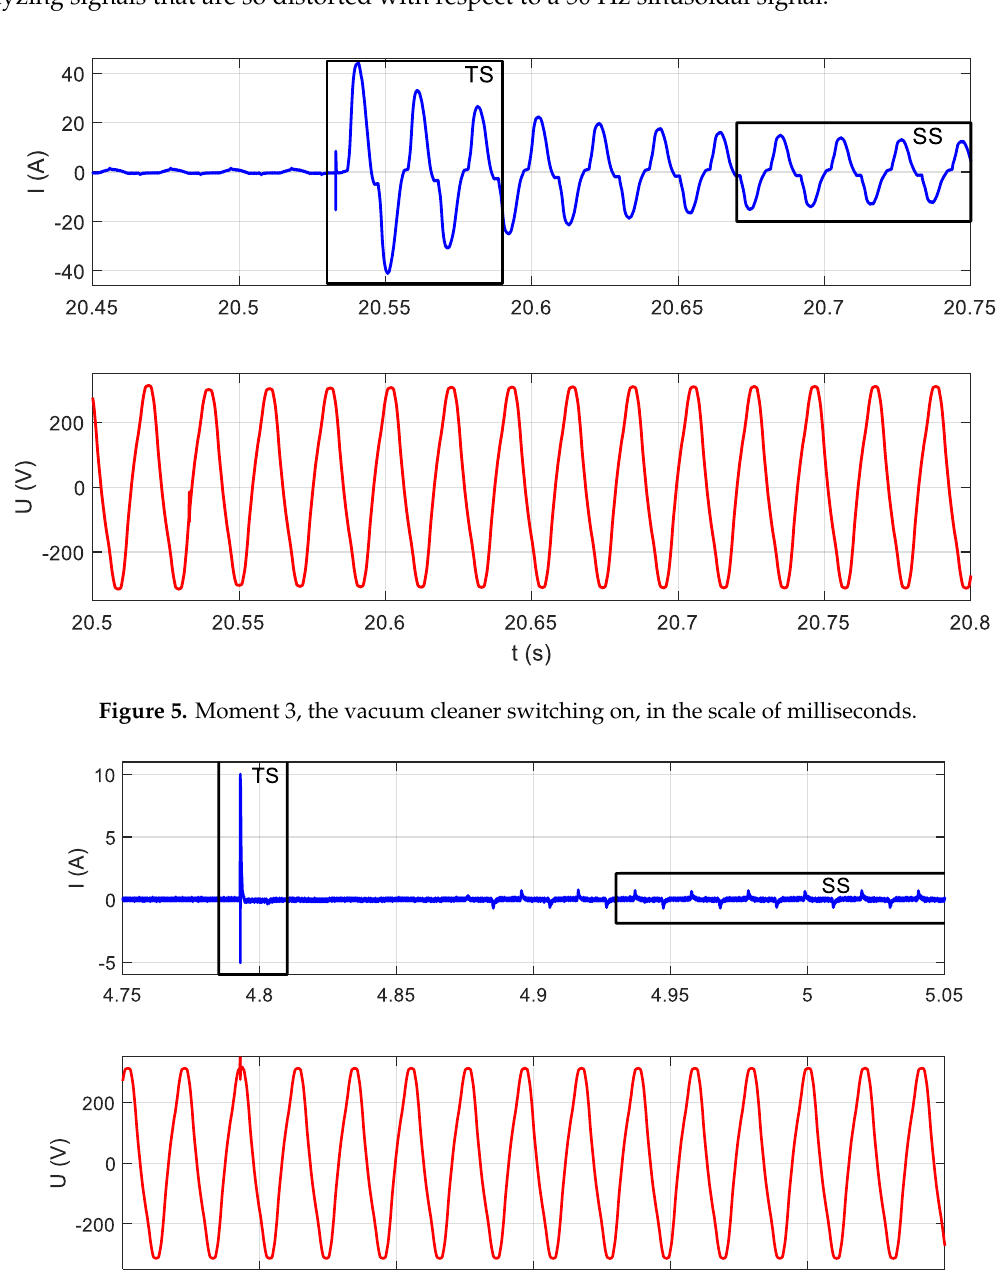
Figure 6. Moment 1, switching on the LED bulb ( A ).